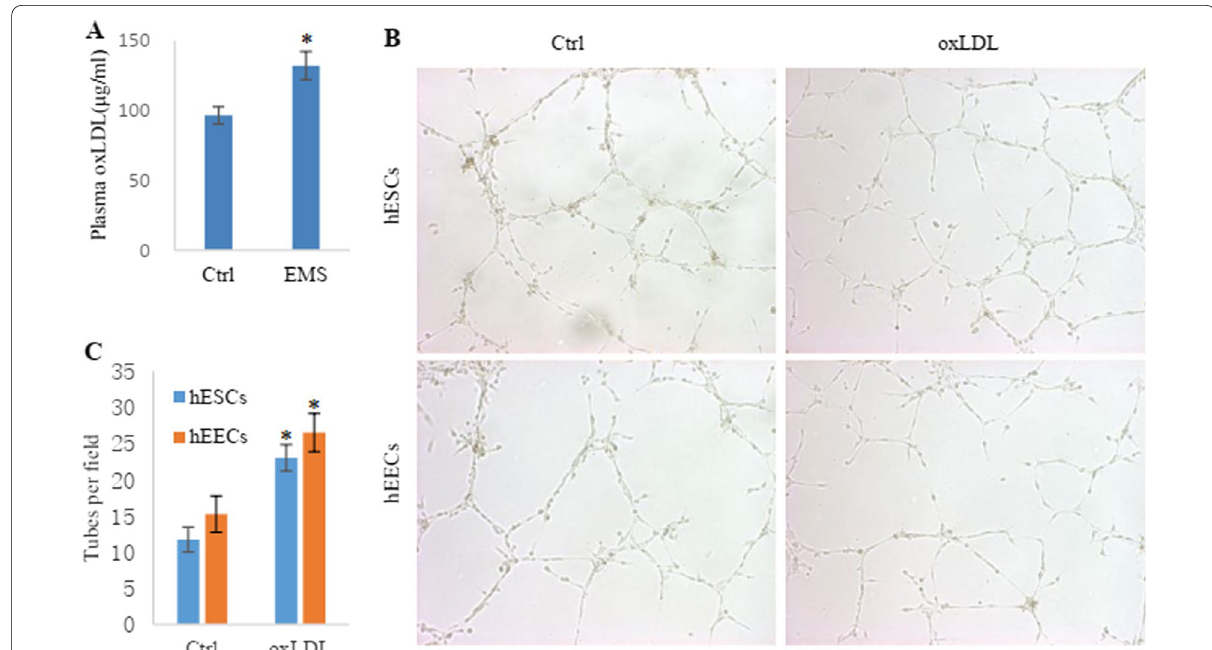
Fig. 2 OxLDL promoted EMS-induced angiogenesis. A The plasma oxLDL level was elevated in EMS patients. The number in each patient group was 8. B , C Tube formation induced by hESCs and hEECs treated with oxLDL and PBS. The histogram represents the tube number in each group. * represents p < 0.05